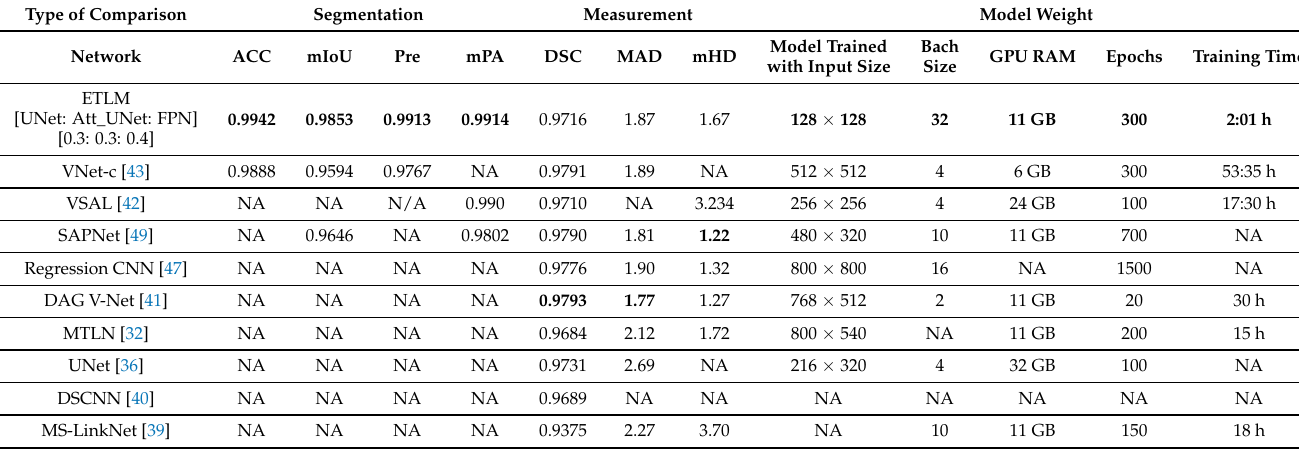
Table 10. Comprehensive comparison with state-of-the-art